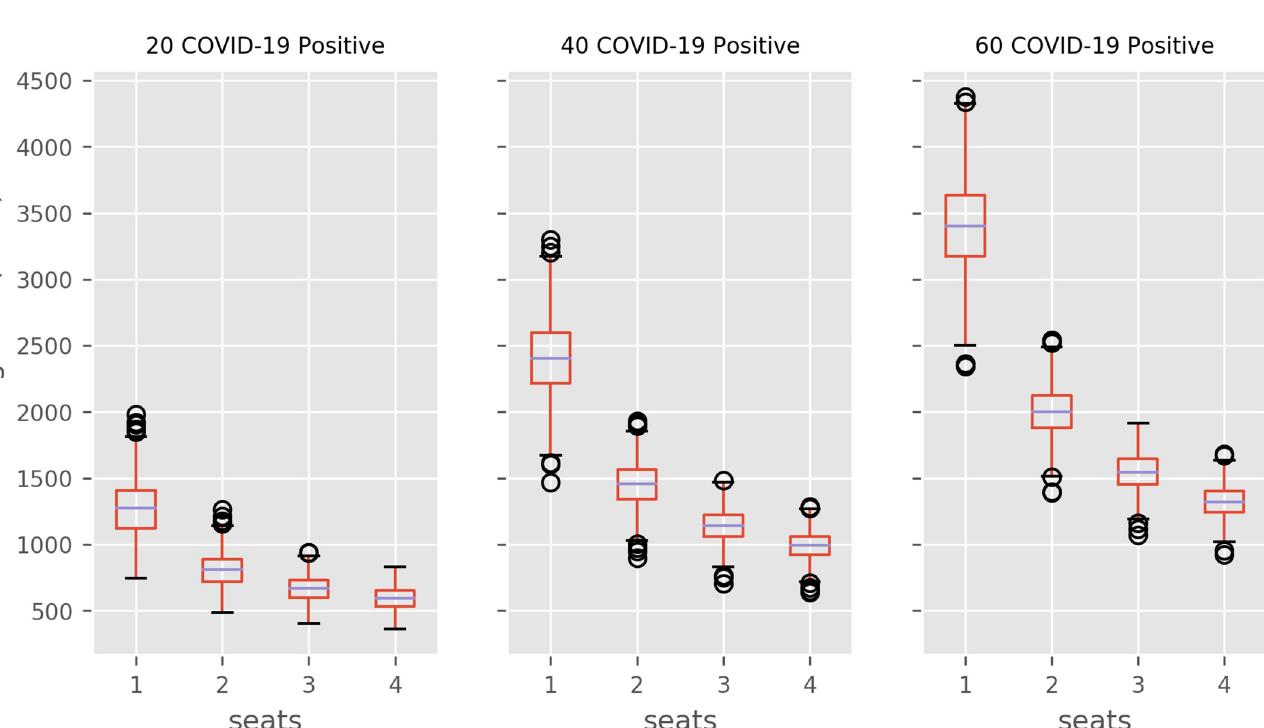
Fig 5. One-way ambulance transport time distributions (1000 model runs). Results compare population COVID-positive and ambulance seating capacity (e.g. 2 = 2 seats.) Figures do not include ambulance clean-down/turnaround time. https://doi.org/10.1371/journal.pone.0237628.g005 PLOS ONE | https://doi.org/10.1371/journal.pone.0237628 August 13,